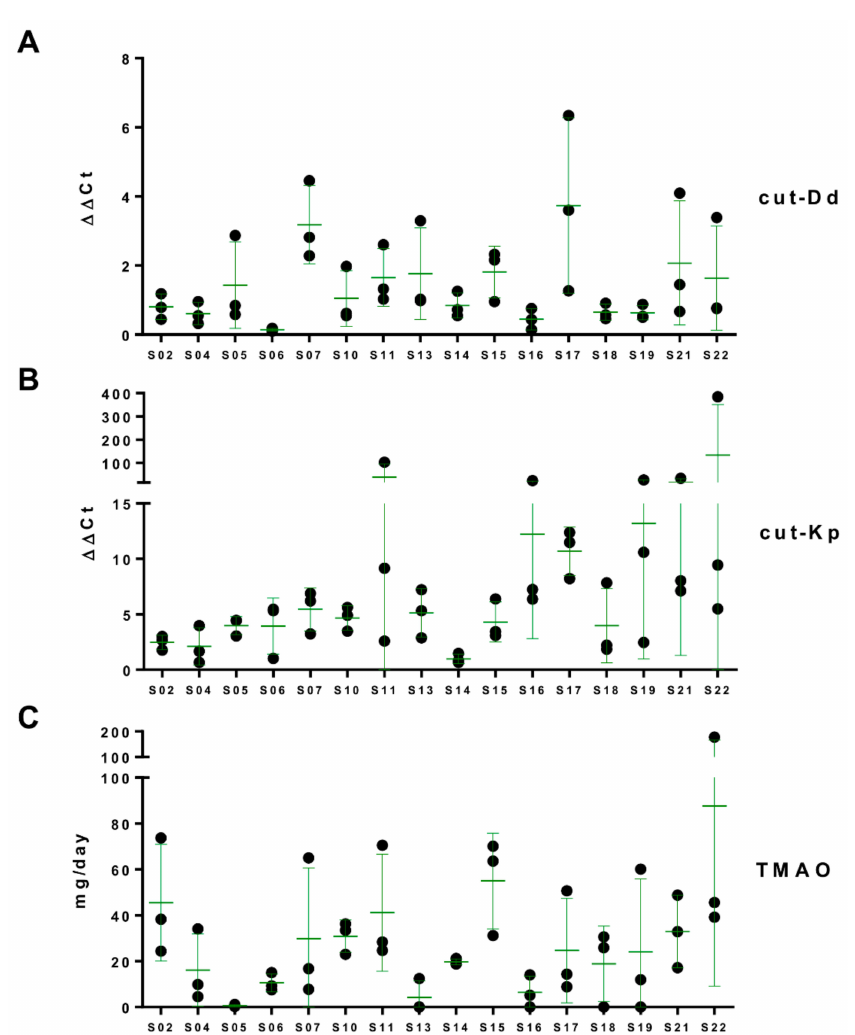
Figure 2. Fecal levels of the cutC gene and daily urinary excretion of trimethylamine-N-oxide (TMAO). The relative abundance of cutC was determined by quantitative real-time polymerase chain reaction (qPCR) with the primer pair cut-Dd-F / R (panel A ) and cut-Kp-F / R ( B ). The TMAO concentration was determined by ultra-performance liquid chromatography coupled with tandem mass spectrometry (UPLC-MS / MS) in urine collected over 24 h ( C ). Green bars represent the mean ± standard deviation of three measurements per